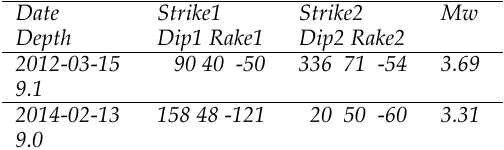
Table 1D. Parameters (strike, dip, and rake of the first and second nodal planes) of focal mechanisms com- puted in this study from the P-wave first-motion polar- ity data: